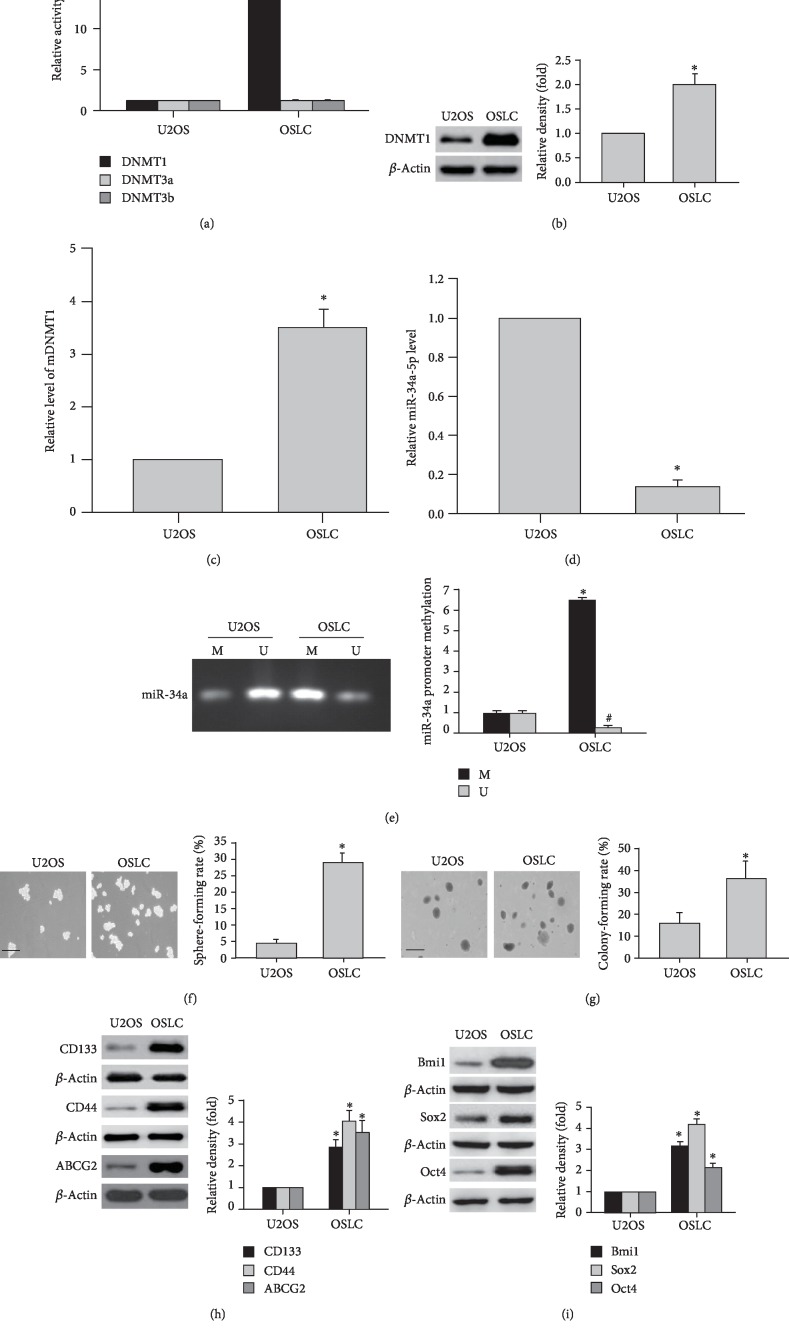
Comparison of stemness between U2OS cells and OSLCs. (a) The activity of DNMTs was determined by ELISA. (b) The level of DNMT1 protein was examined by immunoblot (left) and its densitometric analysis (right), with β-actin as a loading control. (c, d) DNMT1 mRNA and miR-34a-5p were assessed by qRT-PCR. (e) Comparison of miR-34a-5p promoter methylation levels in U2OS cells and OSLCs (M, methylated miR-34a-5p promoter; U, unmethylated miR-34a-5p promoter). (f) Representative images of sphere formation (left) (scale bar, 200 μm), and sphere-forming rate was assessed by the sphere formation assay (right). (g) Representative images of colony formation (left) (scale bar, 200 μm), and colony-forming rate was determined by the colony formation assay (right). (h) The levels of CD133, CD44, and ABCG2 proteins were examined by immunoblot (left) and their densitometric analysis (right). (i) Bmi1, Sox2, and Oct4 mRNA were assessed, with β-actin serving as a loading control. ∗p < 0.05 (n = 3) vs. U2OS cells.